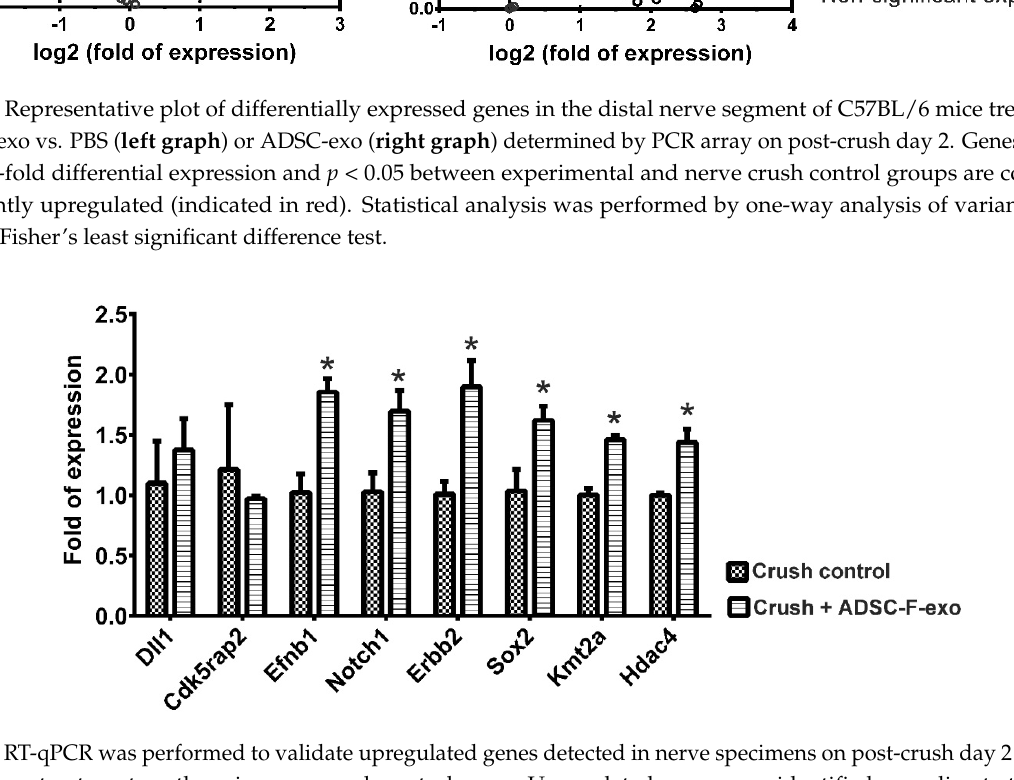
Figure 5. Neurotrophin levels in nerve segments after exosome treatment determined by enzyme-linked immunosorbent assay. Statistical analysis was performed by one-way analysis of variance with a post-hoc Fisher’s least significant differ- ence test. * indicated a statistical significance which was set at p < 0.05. 2.4. Exosomal Protein Content An iTRAQ-based quantitative proteomic analysis was used to analyze expressed ex- osomal proteins in ADSC-exo and ADSC-F-exo samples ( n = 2). The exosomes were la- beled with 4-plex iTRAQ reagents of varying masses (114–117). In total, 1697 proteins were identified, with 192 exosomal proteins noted at the intersection of all four samples (File S1). The biological functions of the upregulated genes were determined using the Gene Ontology and Kyoto Encyclopedia of Genes and Genomes databases. The upregu- lated genes were particularly enriched in the following top ten pathways: focal adhesion (17 proteins), human papillomavirus infection (16 proteins), PI3K-Akt signaling pathway (15 proteins), extracellular matrix-receptor interaction (14 proteins), metabolic pathways (13 proteins), pathways in cancer (13 proteins), complement and coagulation cascades (11 proteins), regulation of actin cytoskeleton (10 proteins), lysosome (10 proteins), and rheu- matoid arthritis (9 proteins). We imported the protein–protein interaction (PPI) data into Cytoscape and constructed a PPI network of exosomal proteins (Figure 6) to disclose the